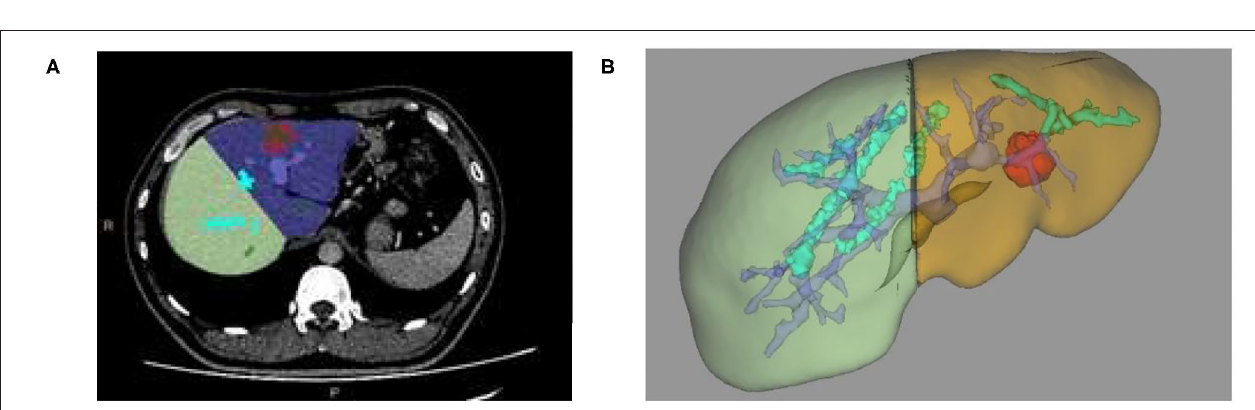
FIGURE 2 | (A) Two-dimensional CT enhanced image, (B) 3D reconstruction based on liver segmentation and tumor growth model on CT